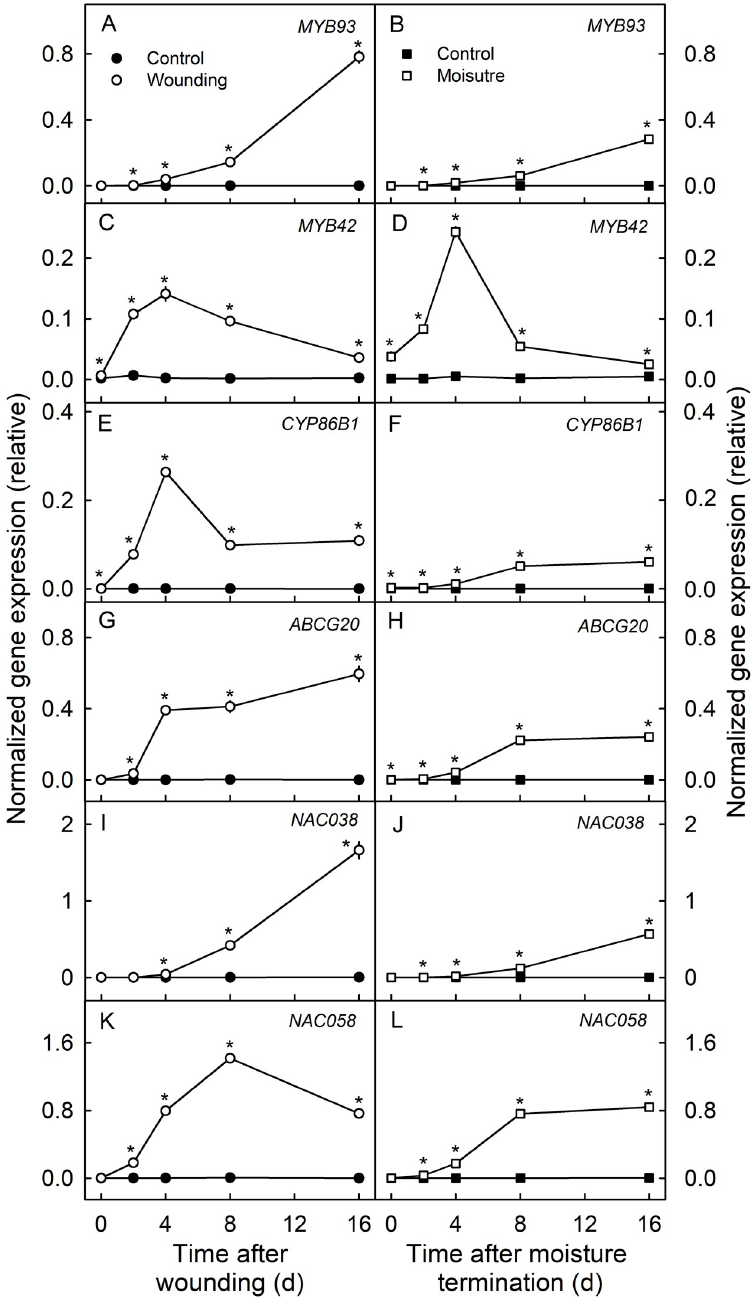
Fig 3. Time courses of change in the expressions of two transcription factors involved in the regulation of the synthesis of suberin ( MYB93 ) and lignin ( MYB42 ), a gene involved directly in the synthesis of suberin monomers ( CYP86B1 ) and a gene involved in the transport of suberin monomers ( ABCG20 ) and two uncharacterized transcription factors ( NAC038 and NAC058 ) in the skin of ‘Pinova’ apple fruit following wounding or following exposure of the fruit surface to moisture. Patches of fruit skin were wounded 40 days after full bloom (DAFB) by abrading the cuticle using fine sandpaper (‘Wounding’). For comparison, microcracks were induced by exposure of skin patches to surface moisture (‘Moisture’). Here, the fruit surface was exposed to surface moisture from 28 to 40 DAFB. Non-treated fruit served as the respective controls (‘Control’). Expression values are means ± SE of three biological replicates comprising six fruit each. The ‘ � ’ indicates significant differences between the wounded patch and its control or between the moisture exposed patch and its control, P � 0.05 (Student’s t-test).